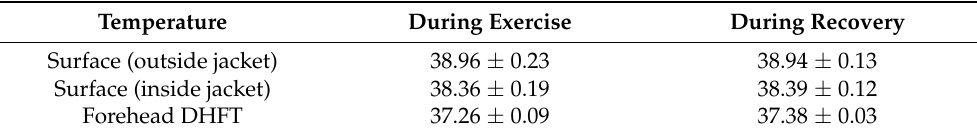
Table 2. Temperatures during the exercise and recovery